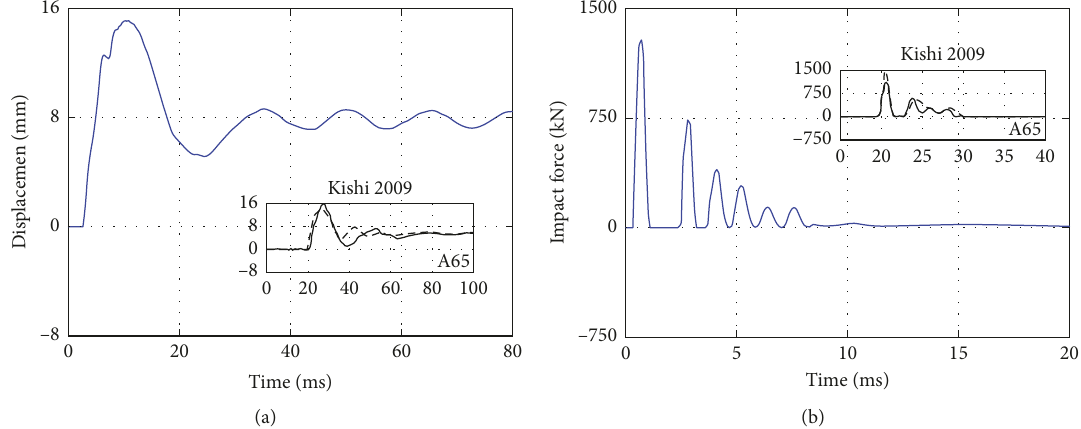
Figure 5: Finite element model of RC beam. (a) Concrete element. (b) Reinforcement element.